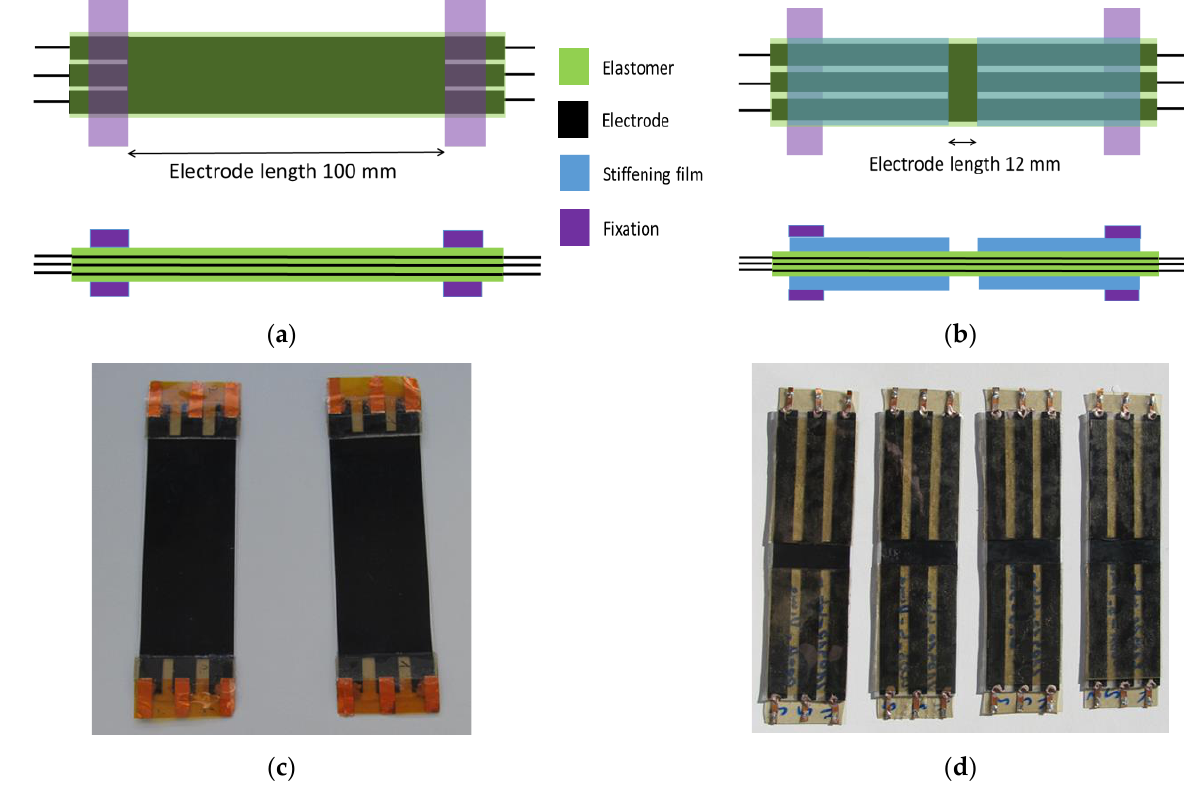
Figure 11. Scheme of a conventional DE strain sensor with two dielectric layers, three electrode layers and two outer protective layers in top view and in side view ( a ), scheme of an advanced DE strain sensor with the same layers in the center zone and two stiffening elements at both ends in top view and in side view ( b ) and photographs of conventional ( c ) and advanced strain sensors ( d ) [101]. When the whole sensor is stretched, the strain only occurs in the short active zone.